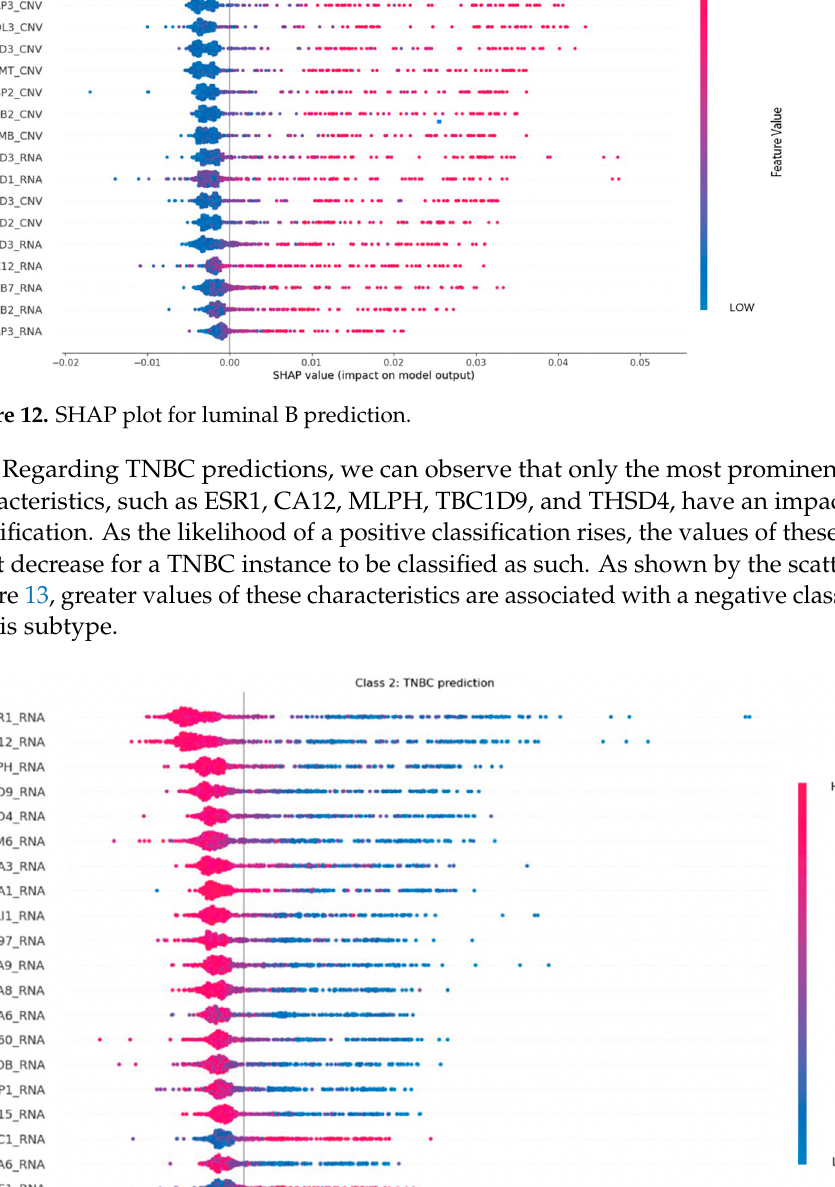
Figure 14. SHAP plot for ERBB2 predictions. 4.4. Results Summary The best results obtained throughout the three steps of the proposed framework, as shown in Figure 1, are summarized in Table 14. We can clearly see the benefit of perform- ing several levels of feature integration and selection as results improve while progressing from one step to the next. The best results were achieved using the extra trees classifier with two levels of feature selection.